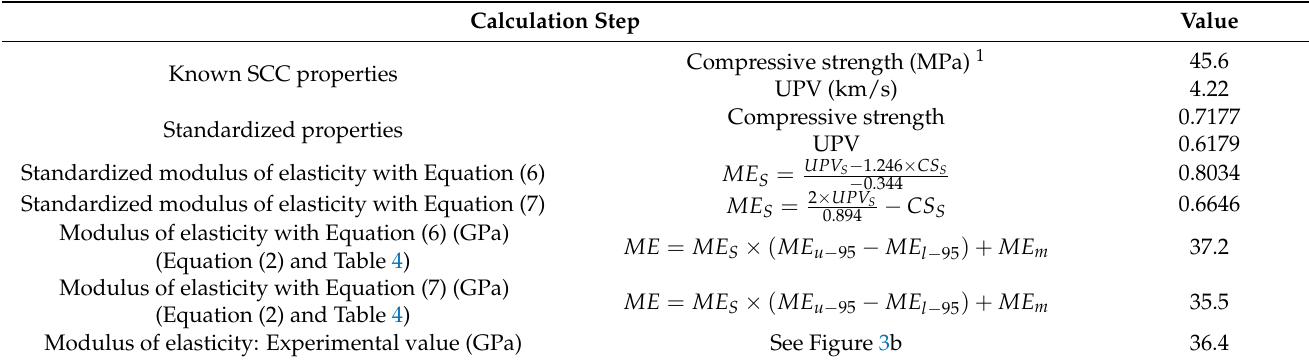
Table 6. Calculation of the modulus of elasticity of mix L0 with the proposed